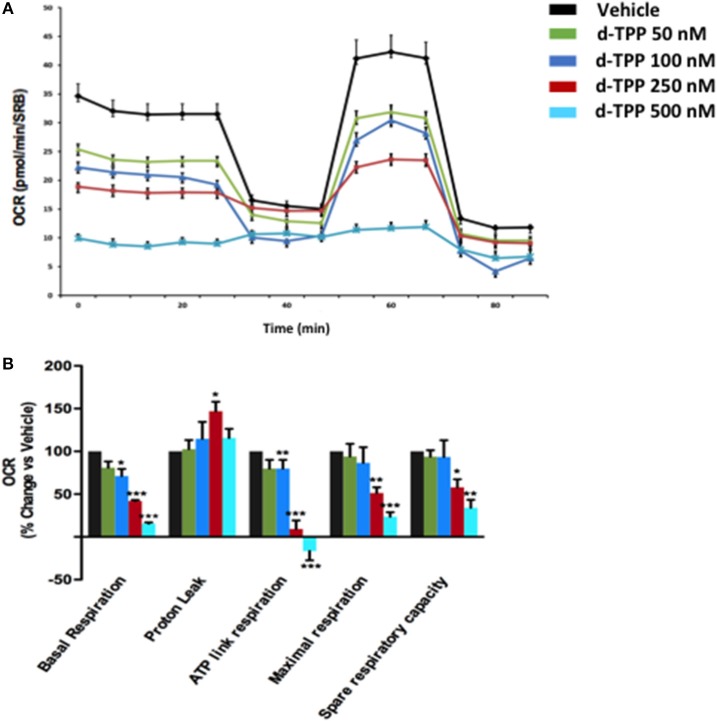
Mitochondrial respiration is inhibited in MCF-7 cells treated with d-TPP. The metabolic profile of MCF-7 cells treated with increasing concentrations of d-TPP (50–500 nM) was assessed using the Seahorse XFe96 analyzer. (A) Representative tracings of metabolic flux. Dose-dependent significant reductions in basal respiration, maximal respiration, ATP levels, and spare respiratory capacity were observed (B). Data shown are the mean ± SEM of 3 independent experiments performed in sextuplicate. *p < 0.05; **p < 0.01; ***p < 0.001 indicates significance, all relative to the vehicle-alone treated cells.